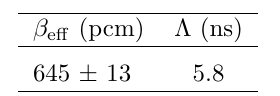
Table 13. Godiva benchmark model kinetics parameters.